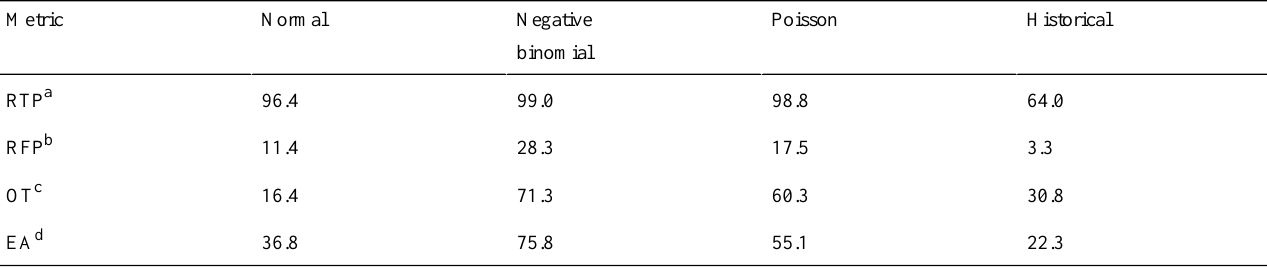
Table 2. Average percentages of various performance metrics for various categories of